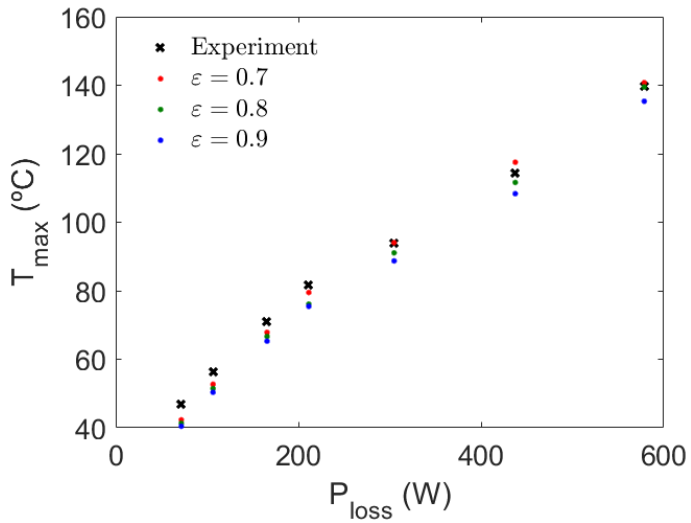
Figure 10. Comparison of the maximum temperature measured in the prototype and the numerical model estimation for the cases listed in Table 1 for various surface emissivity values.